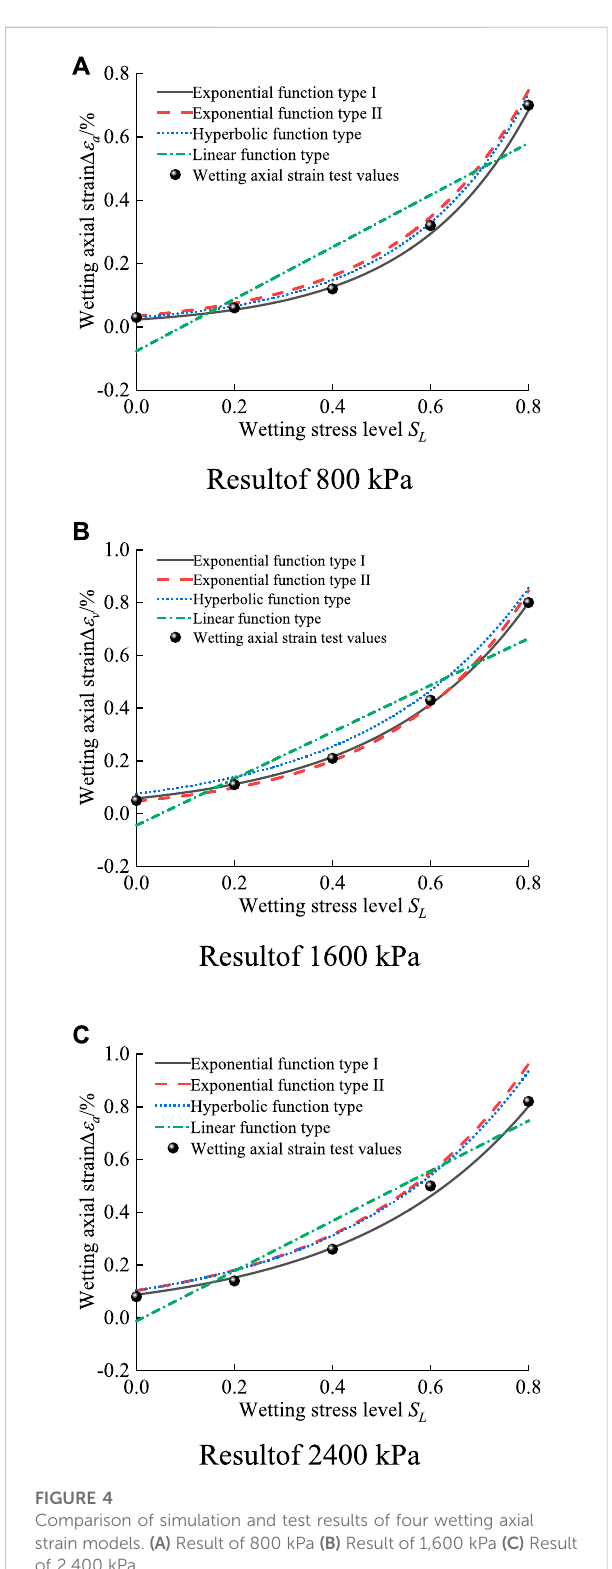
FIGURE 4 Comparison of simulation and test results of four wetting axial strain models. (A) Result of 800 kPa (B) Result of 1,600 kPa (C) Result of 2,400 kPa.